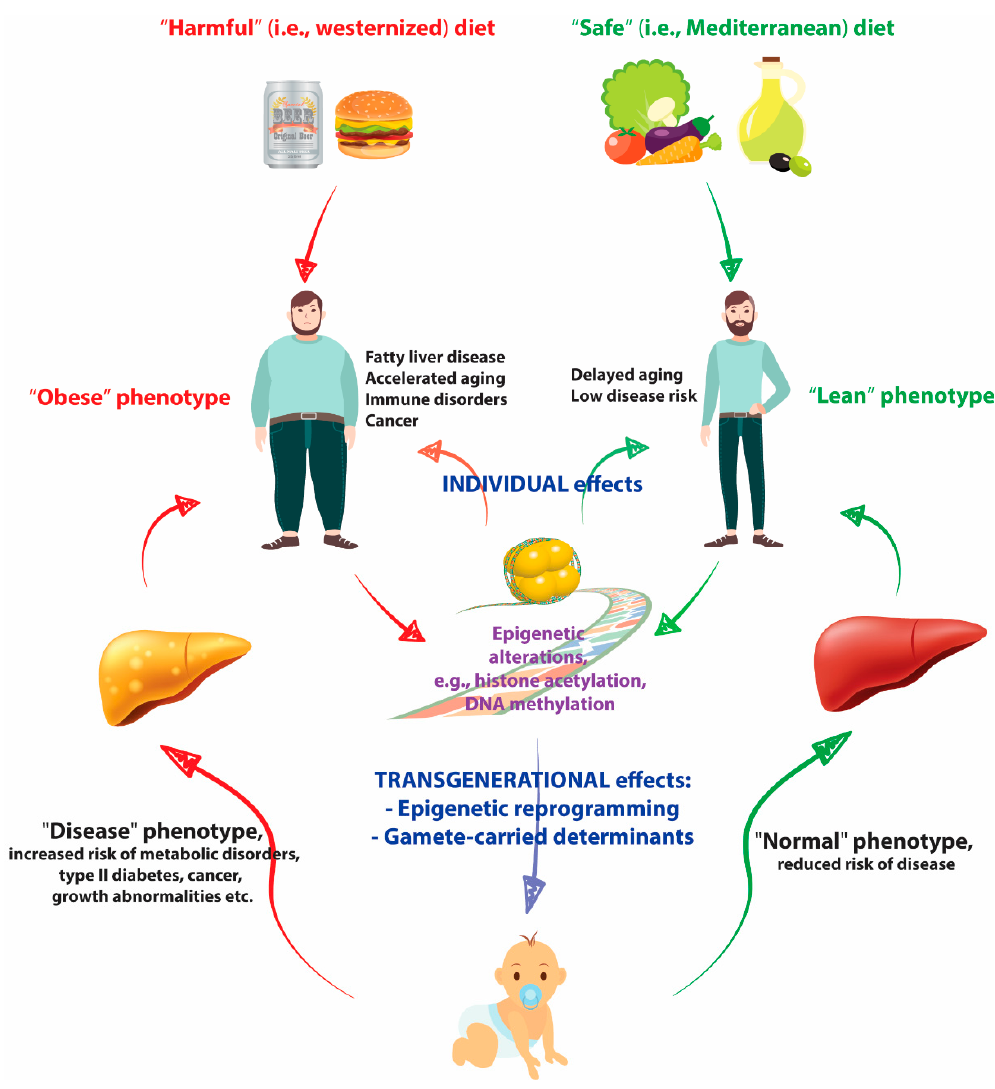
Figure 1. The diet affects the epigenome to modify individual and transgenerational phenotypes.